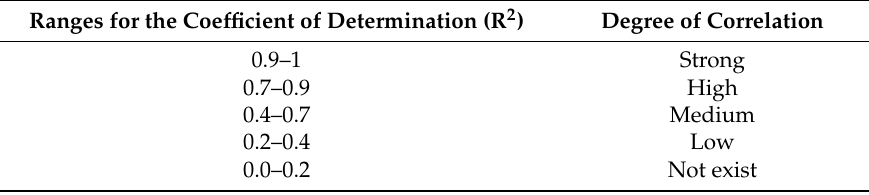
Table 4. The defined degree of